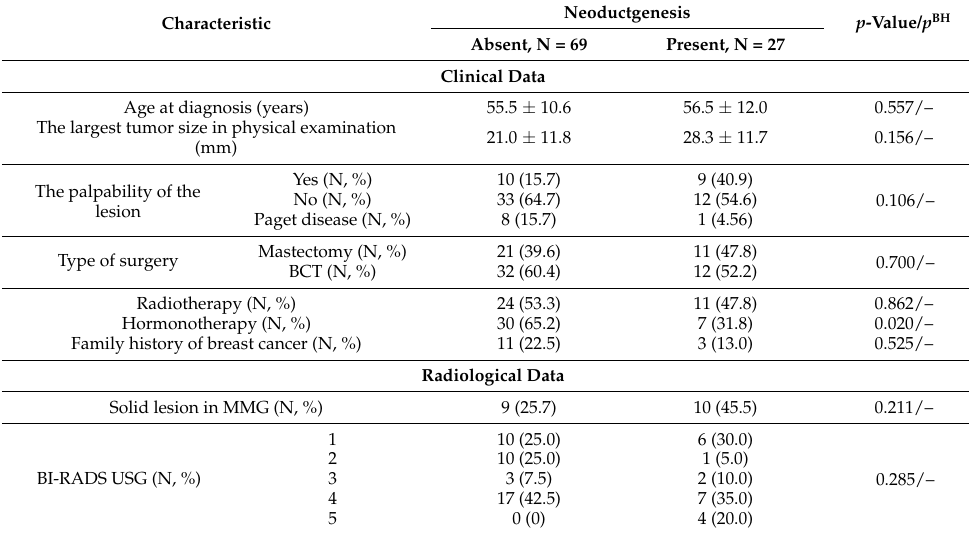
Table 3. Clinical and radiological characteristic of DCIS with or without neoductgenesis as scores